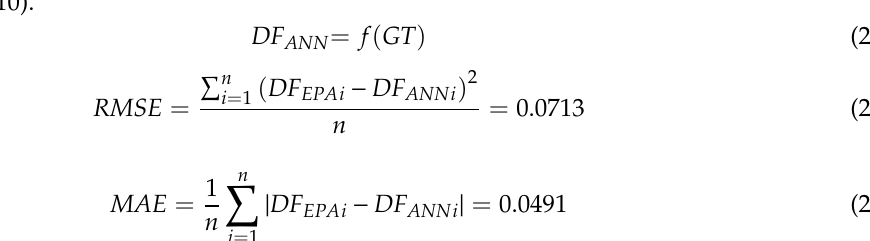
Equations (9) and (10).